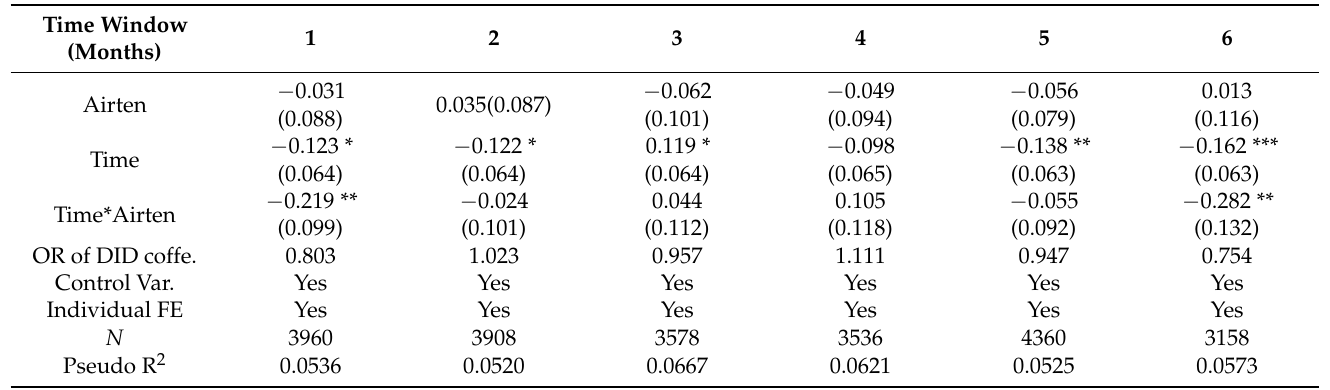
Table 4. Results of different time window ordinal logistic regression analysis.